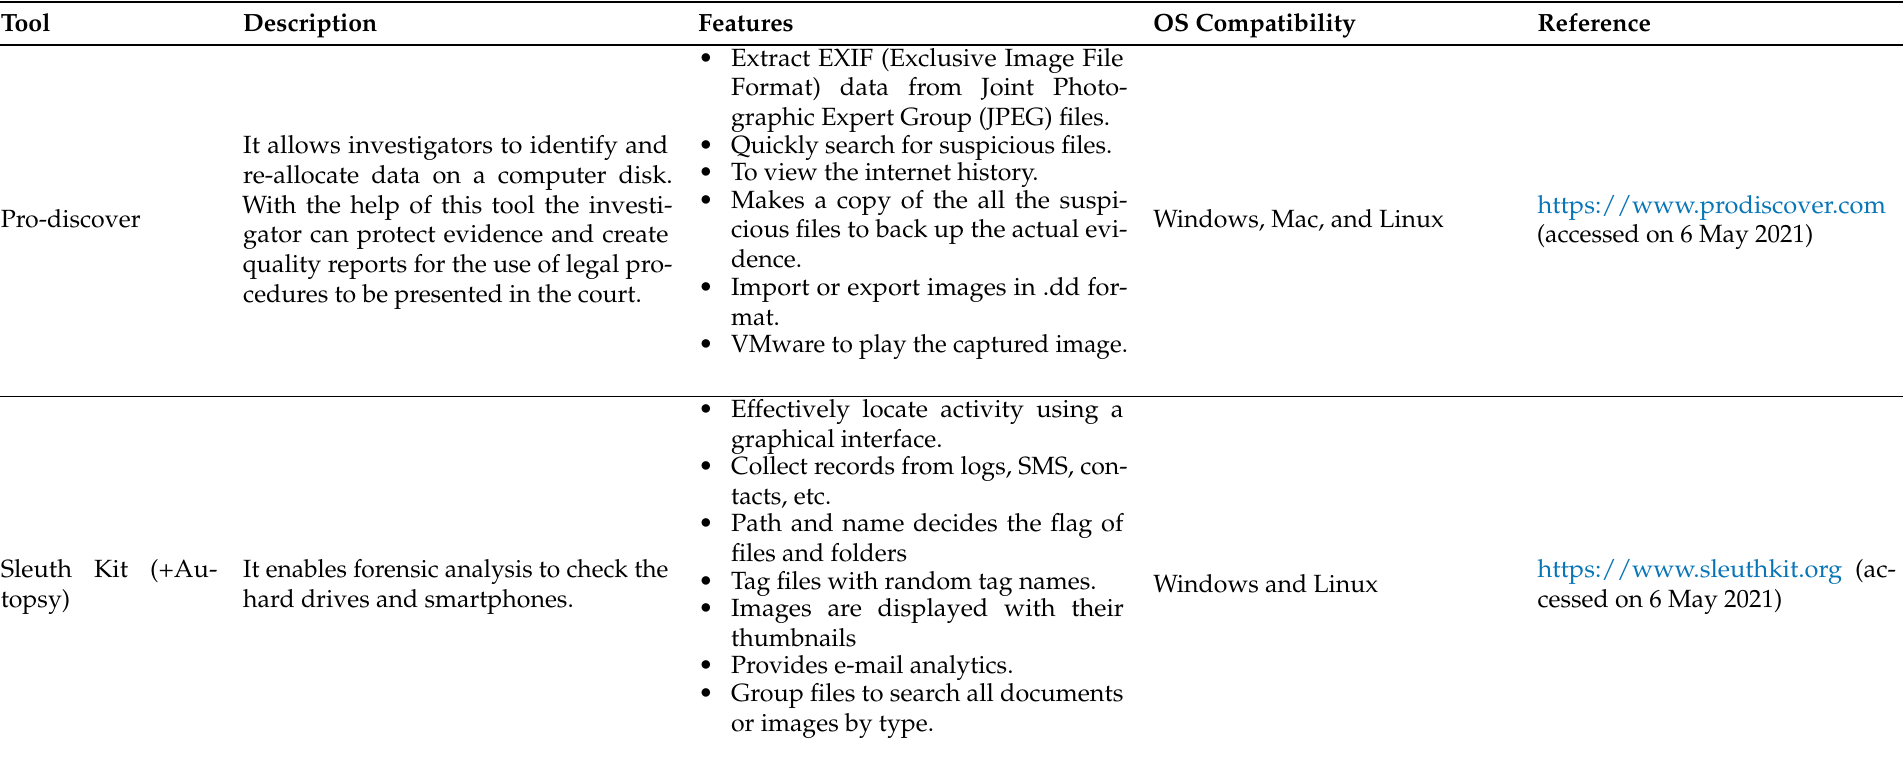
Table 3. Software tools for digital forensic analysis in Cloud/Edge